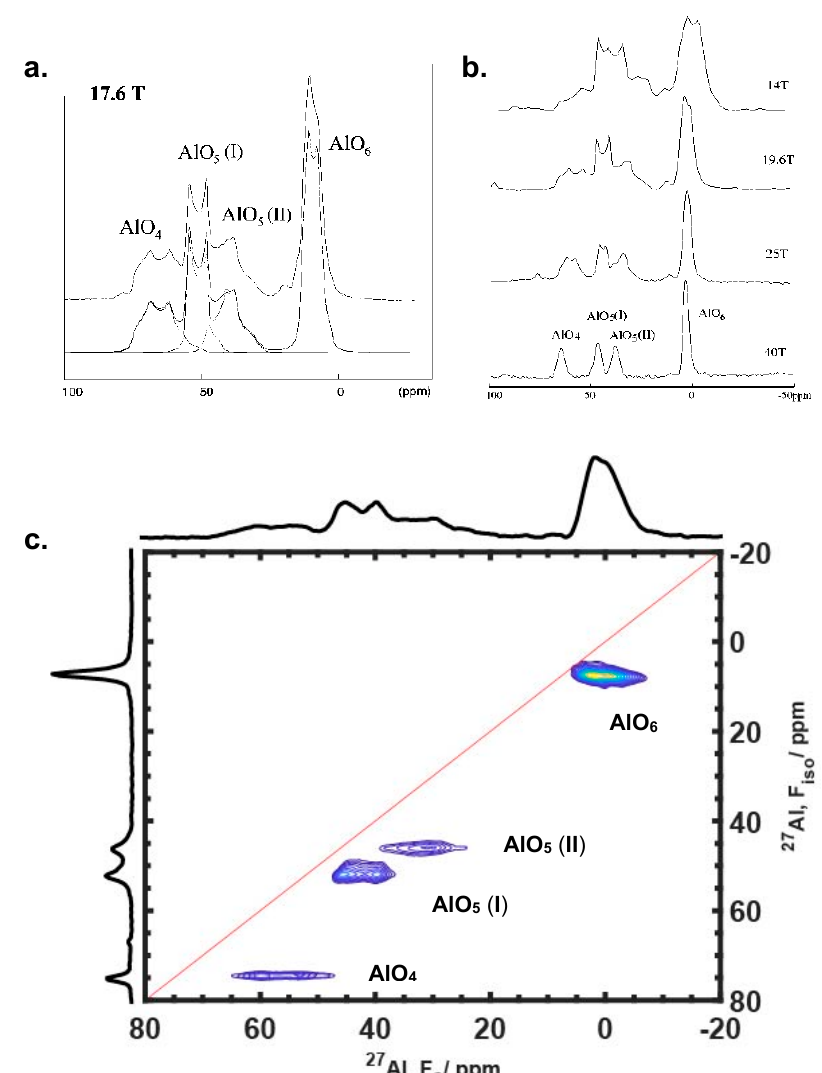
Figure 6. 27 Al MAS NMR of A9B2 (9Al 2 O 3 · 2B 2 O 3 ) acquired at 17.6 T showing the deconvolution of four sites ( a ) and, at four different fields 14, 19.6, 25 and 40 T showing field-dependent resolution enhancement ( b ). All four sites are completely resolved at 40 T where quadrupolar broadening is majorly removed. The peaks are also resolved in the 2D MQMAS spectrum at 19.6 T as shown in ( c ). ( a , b ) are reprinted (adapted) with permission from Ref. [22]. Copyright (2002) American Chemical Society. ( c ) was acquired at 19.6 T at National High Magnetic Field Laboratory (NHMFL).